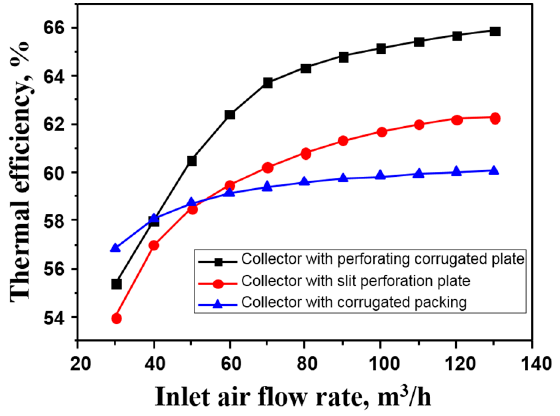
Figure 9. Effects of inlet air flow rate on the thermal efficiency.